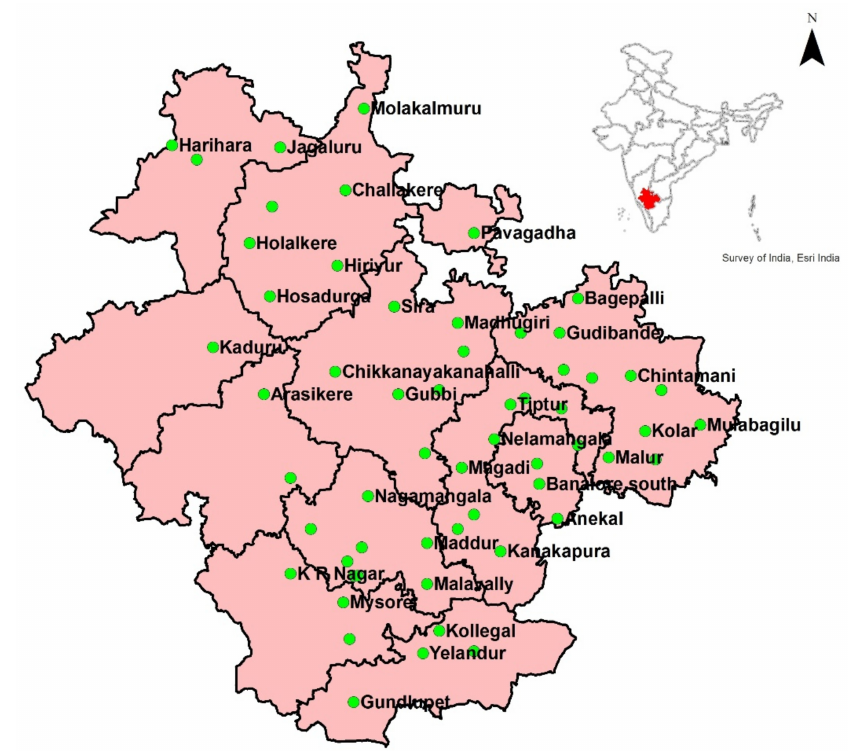
Figure 1. Study area and location of rainfall recording stations.